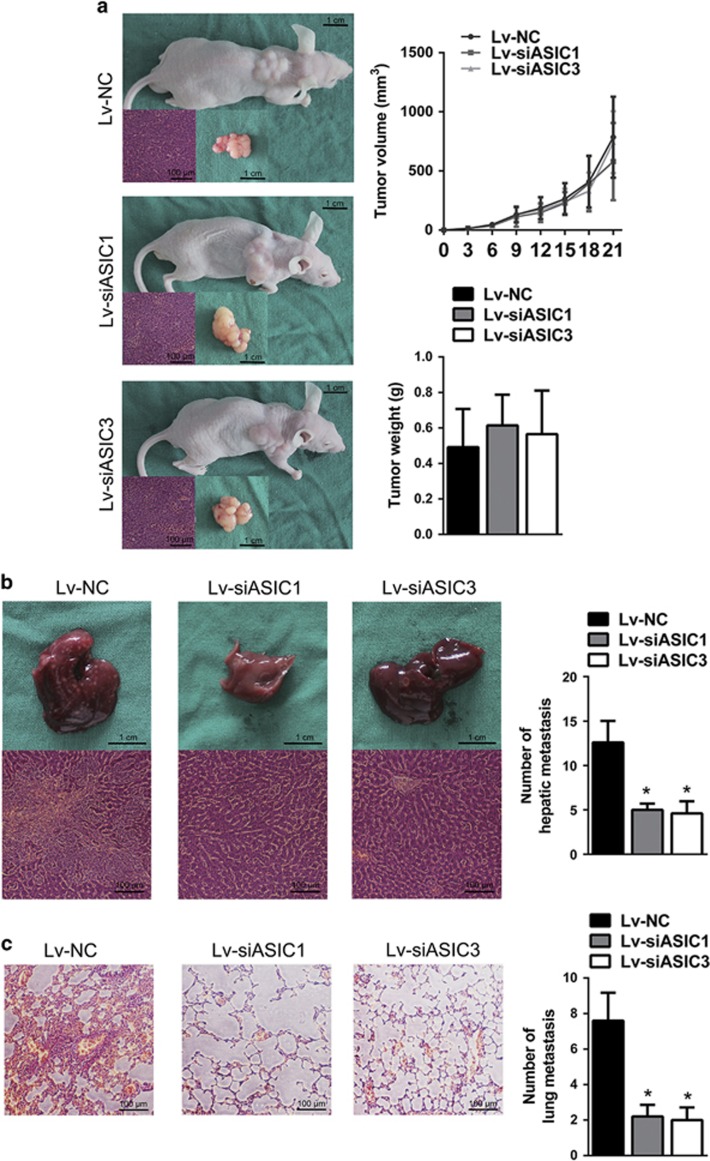
Knockdown of ASIC1 and ASIC3 inhibits metastasis of pancreatic cancer cells in vivo. (a) Photographs of nude mice and tumor showed subcutaneous xenograft of BxPC-3, which was transfected with lentivirus containing sequence of ASIC1 siRNA, ASIC3 siRNA or negative control (Lv-siASIC1, Lv-siASIC3 and Lv-NC). H&E stain confirmed tumor formation. Graph represented tumor volumes at the indicated days during the experiment and tumor weight after mice were killed. (b) Pictures of liver and H&E stain showed liver metastases of subcutaneous xenograft. The histogram showed average number of live metastases in each group. (c) H&E stain showed lung metastases of subcutaneous xenograft. The histogram showed average number of lung metastases in each mouse. The data represent the mean±S.D. (*P<0.05)